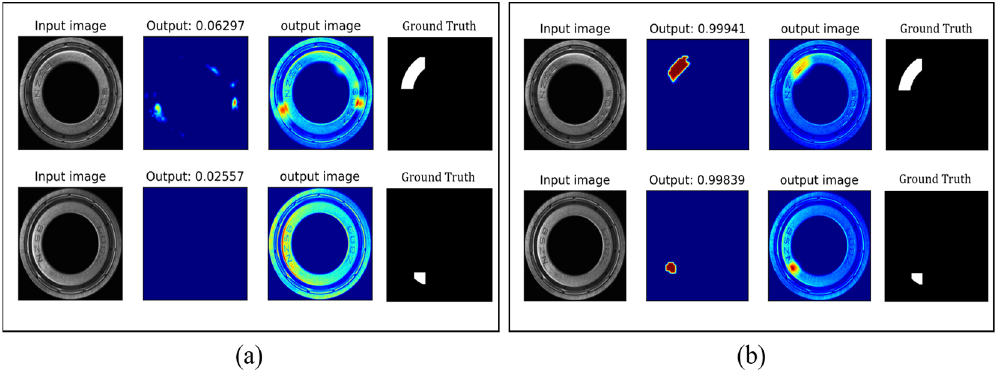
Figure 13. Comparison of PFFM results (with weight label). ( a ) Without PFFM. ( b ) With PFFM.